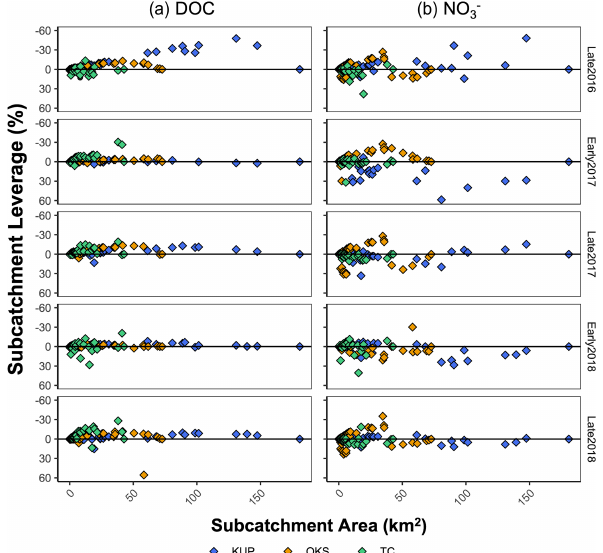
Figure 11. Scatter plot of (a) DOC and (b) NO 3 − leverages across subcatchment area (km 2 ) or each repeated sampling in the Kuparuk River (blue points), Oksrukuyik Creek (orange points), and Trevor Creek (green points) watersheds. Note reversed axes for ease of in- terpretation: negative values above the 0 line indicate production; positive values below the 0 line indicate